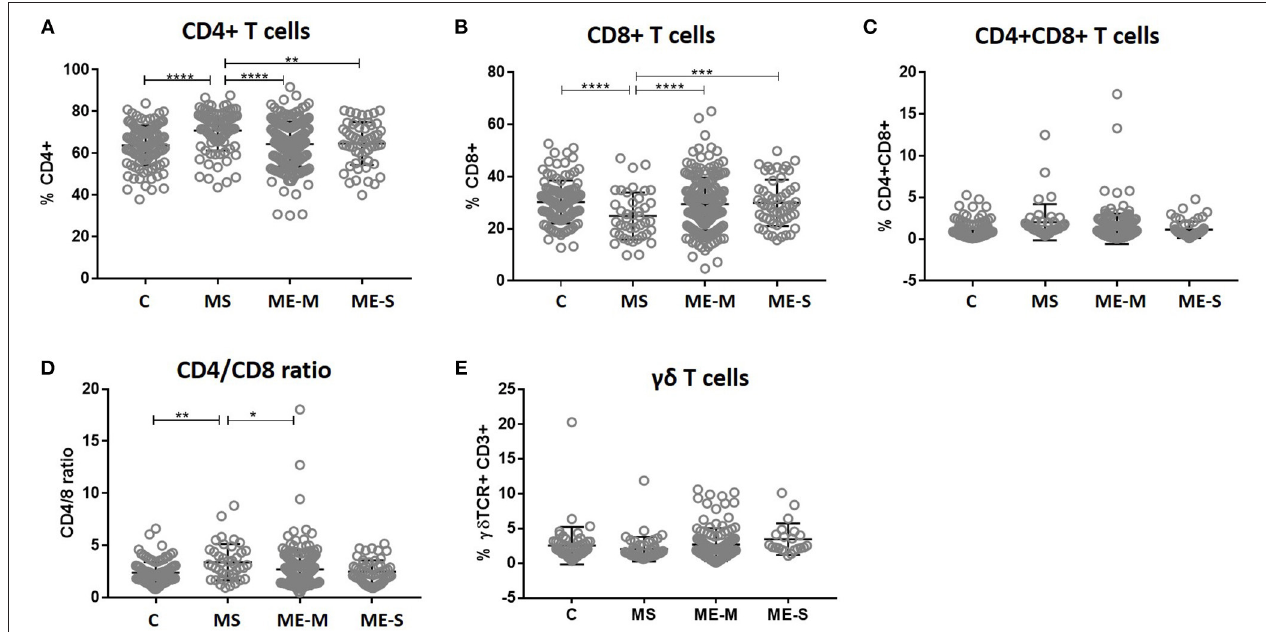
FIGURE 3 | T cell subset quantification in PBMC from people with ME/CFS, people with MS and healthy controls. Within the T cell gate (CD3 + ), the CD4 + and CD8 staining was characterised to calculate the proportion of (A) CD4 + T cells, (B) CD8 + T cells, (C) double positive CD4 + CD8 + T cells, and (D) the ratio of CD4 + :CD8 + T cells. (E) The proportion of T cells which expressed the γδ TCR within the CD3 + T cell population were determined. Data are from healthy controls (C: n = 107), multiple sclerosis (MS: n = 46), mild/moderate ME/CFS (ME-M: n = 197), and severely affected ME/CFS (ME-S: n = 54) for (A–D) , and from C ( n = 56), MS ( n = 46), ME-M ( n = 120), and ME-S ( n = 21) for (E) . Clinical groups were compared by Kruskal-Wallis test for non-parametric data: * P < 0.05, ** P < 0.01, *** P < 0.001, **** P < 0.0001.